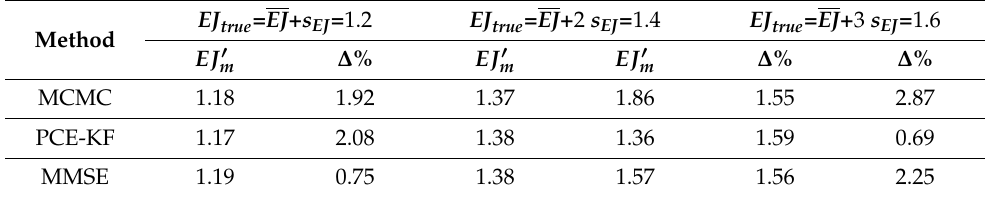
Table 8. Comparison of posterior mode EJ (cid:48) m and EJ true according to different updating procedures. Method